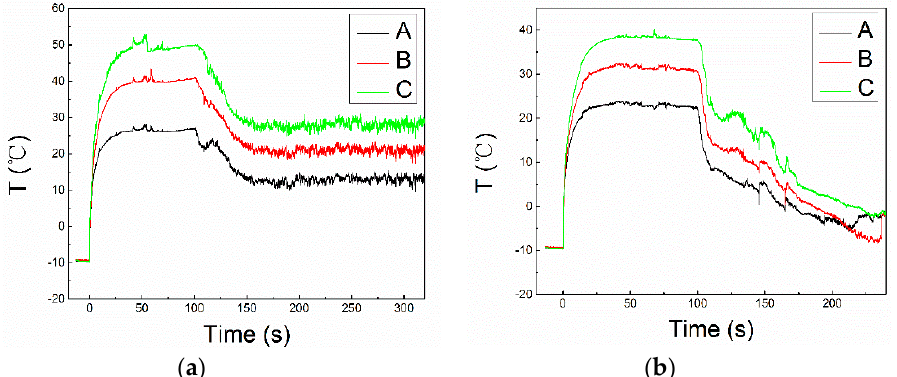
Figure 16. Time variations of surface temperature at the location of selected points: ( a ) LV-HF discharge; ( b ) HV-LF discharge.